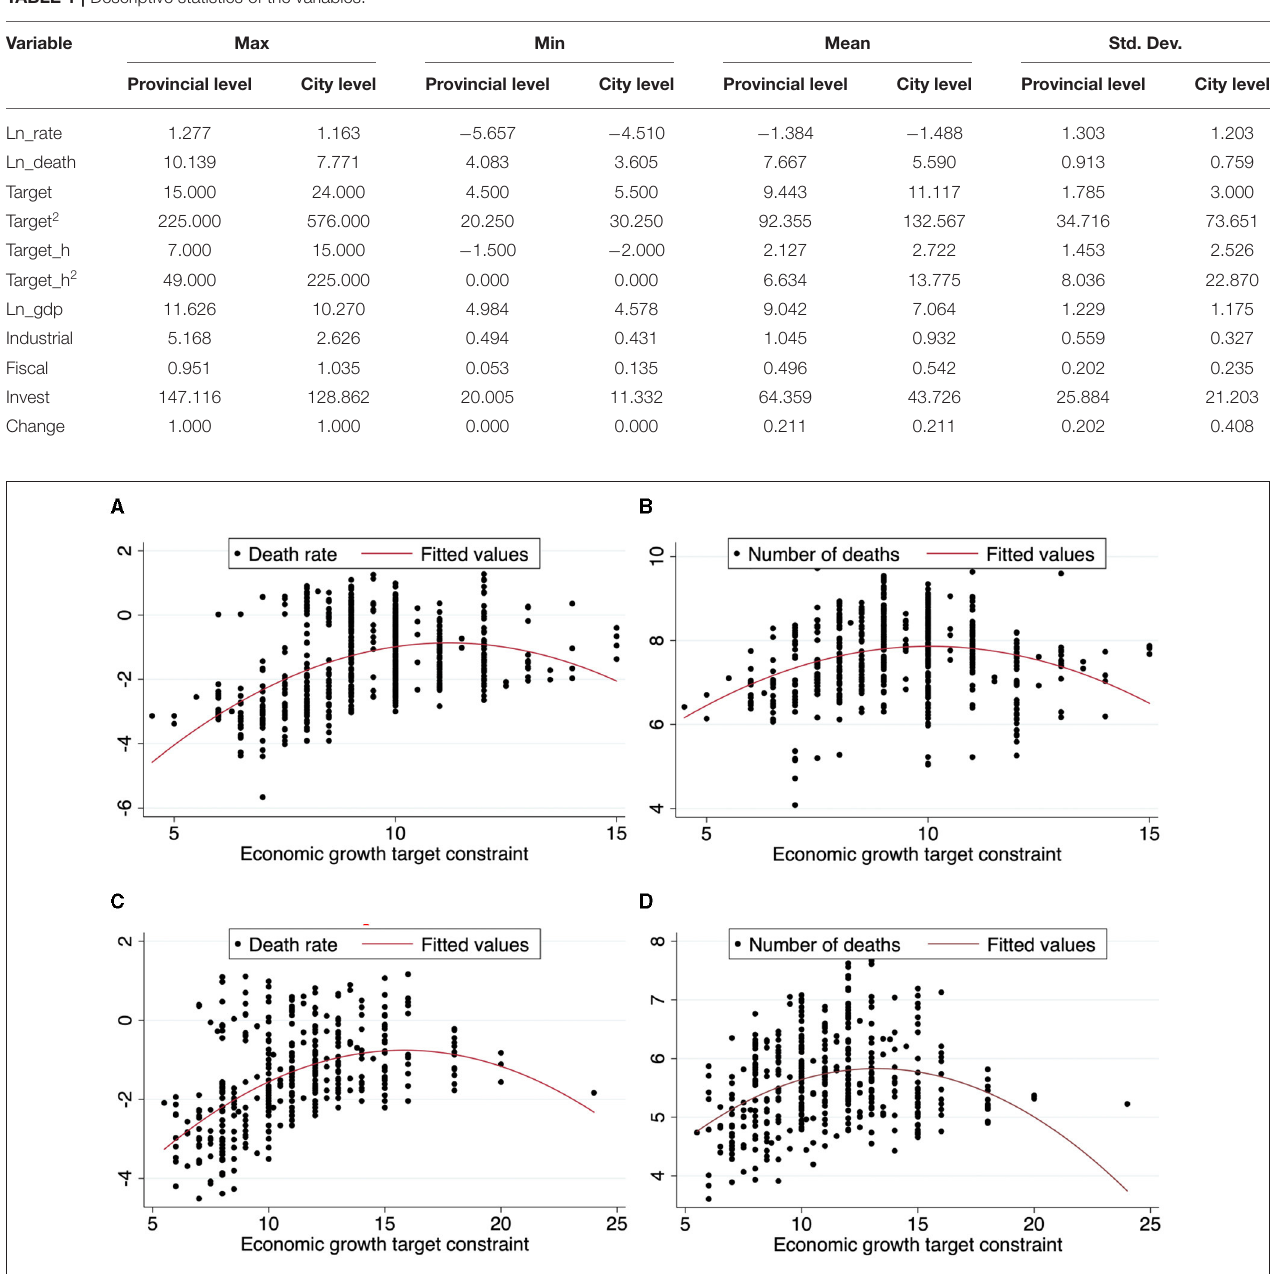
FIGURE 1 | The scatter diagram of the relationship between economic growth target constraint and the quality of public occupational health. (A) Economic growth target constraint and death rate at provincial level. (B) Economic growth target constraint and number of deaths at provincial level. (C) Economic growth target constraint and death rate at city level. (D) Economic growth target constraint and number of deaths at city